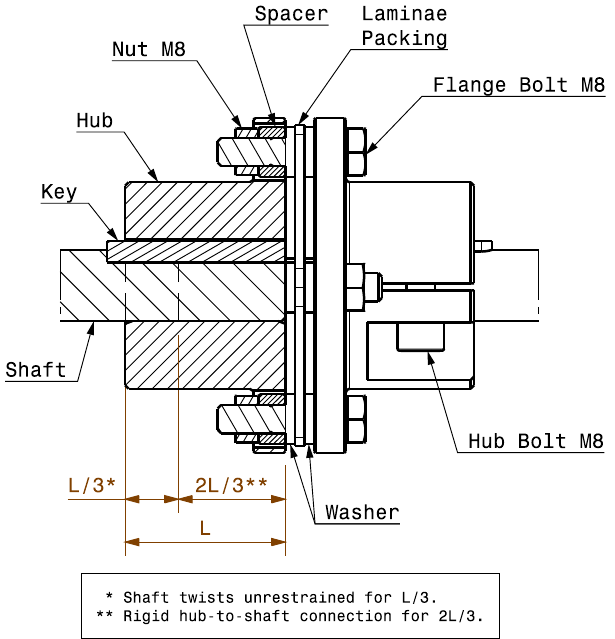
Figure 2. Coupling shaft penetration assumption for a SPF =